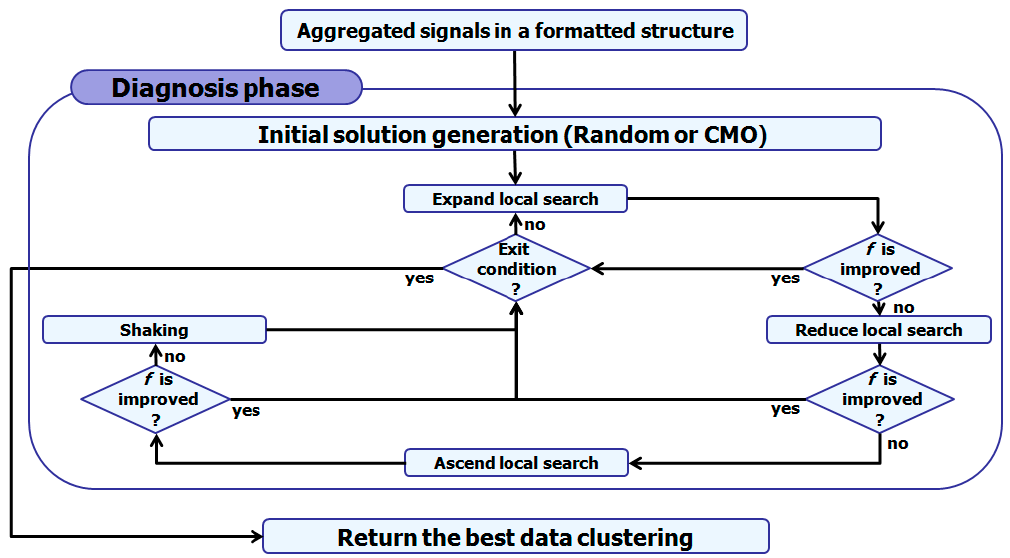
Figure 4. Workflow of the diagnosis